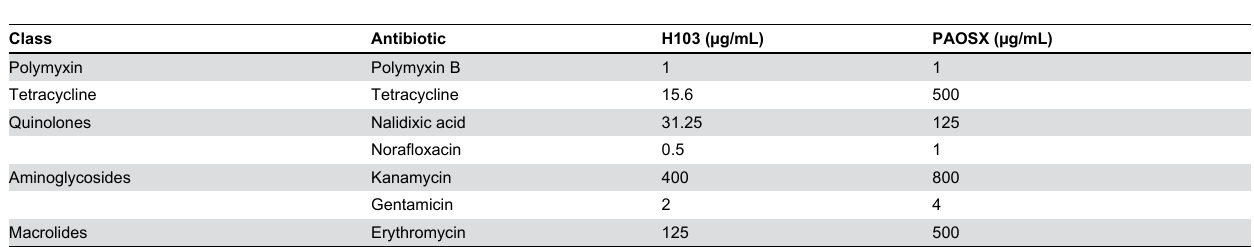
Table 3. MICs to antibiotics.